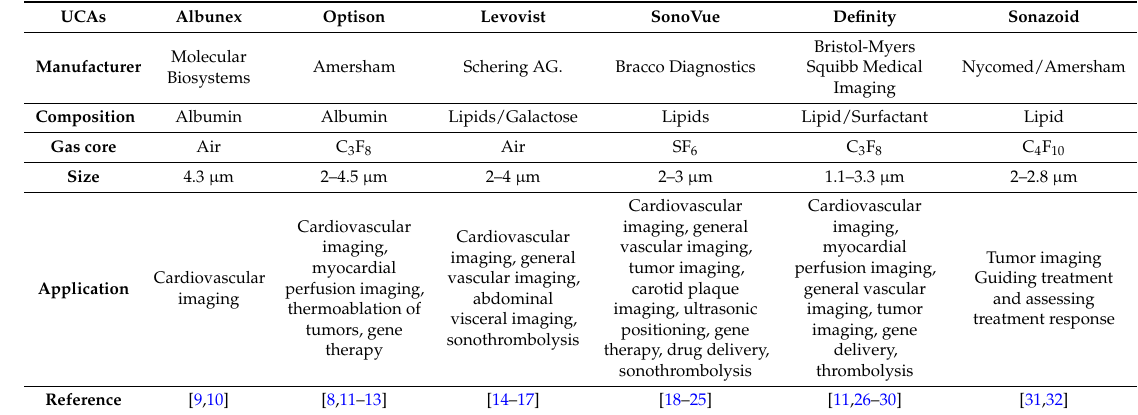
Table 1. Frequently used commercial UCAs (ultrasound contrast agents) in clinics.